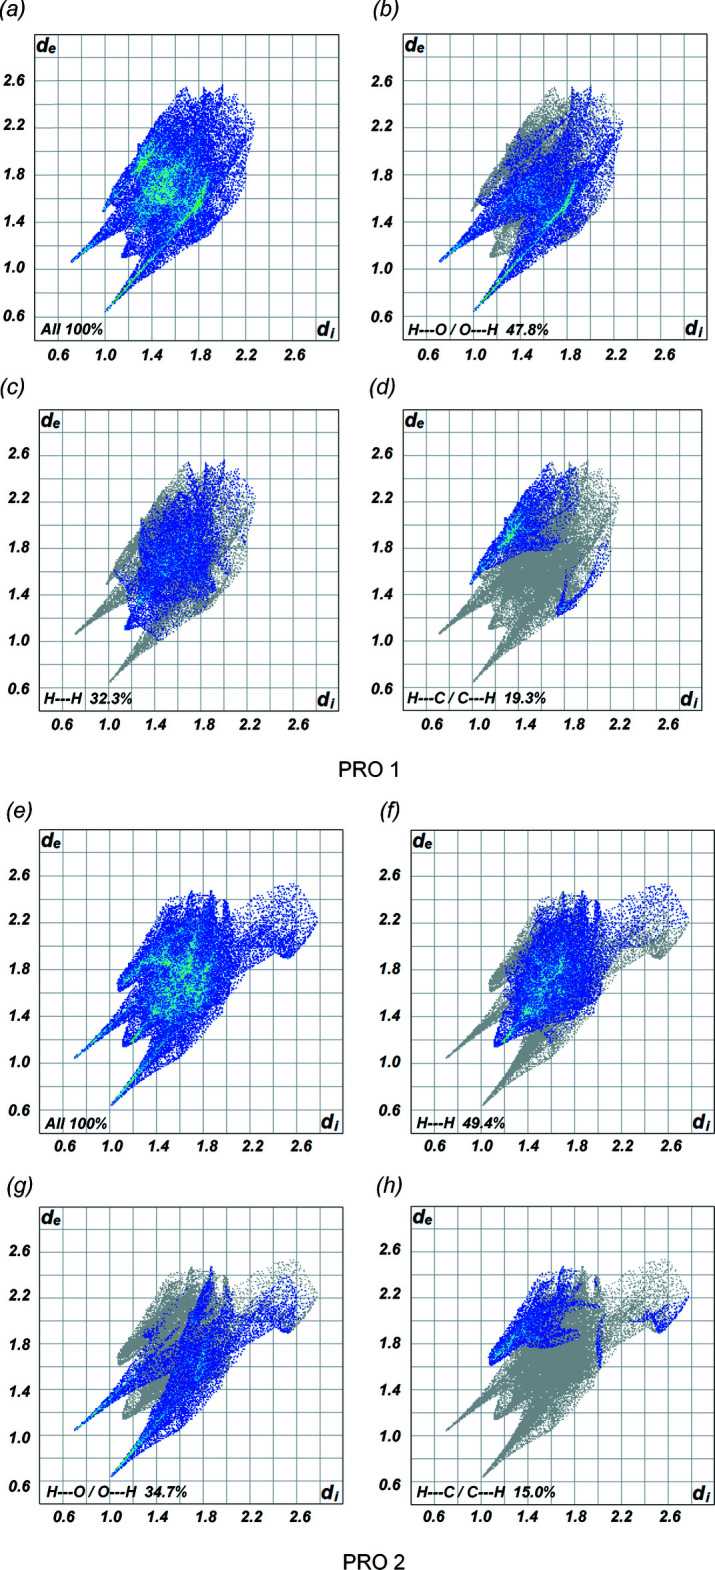
Fingerprint plots for the PRO mol­ecules in (II): (a)–(d) of PRO 1 and (e)–(h) of PRO 2.